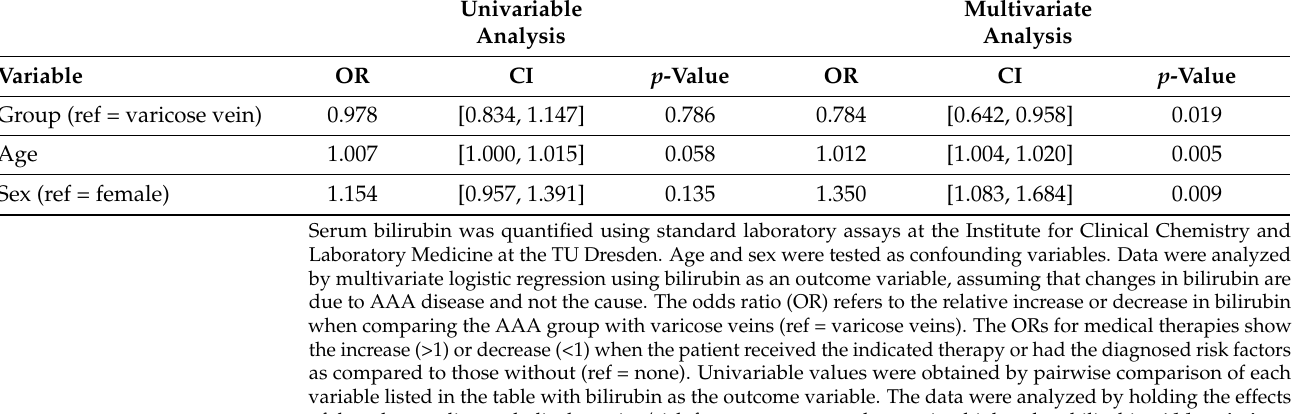
Table 5. Serum bilirubin concentrations and associations with AAA disease, age, and sex. Univariable Analysis